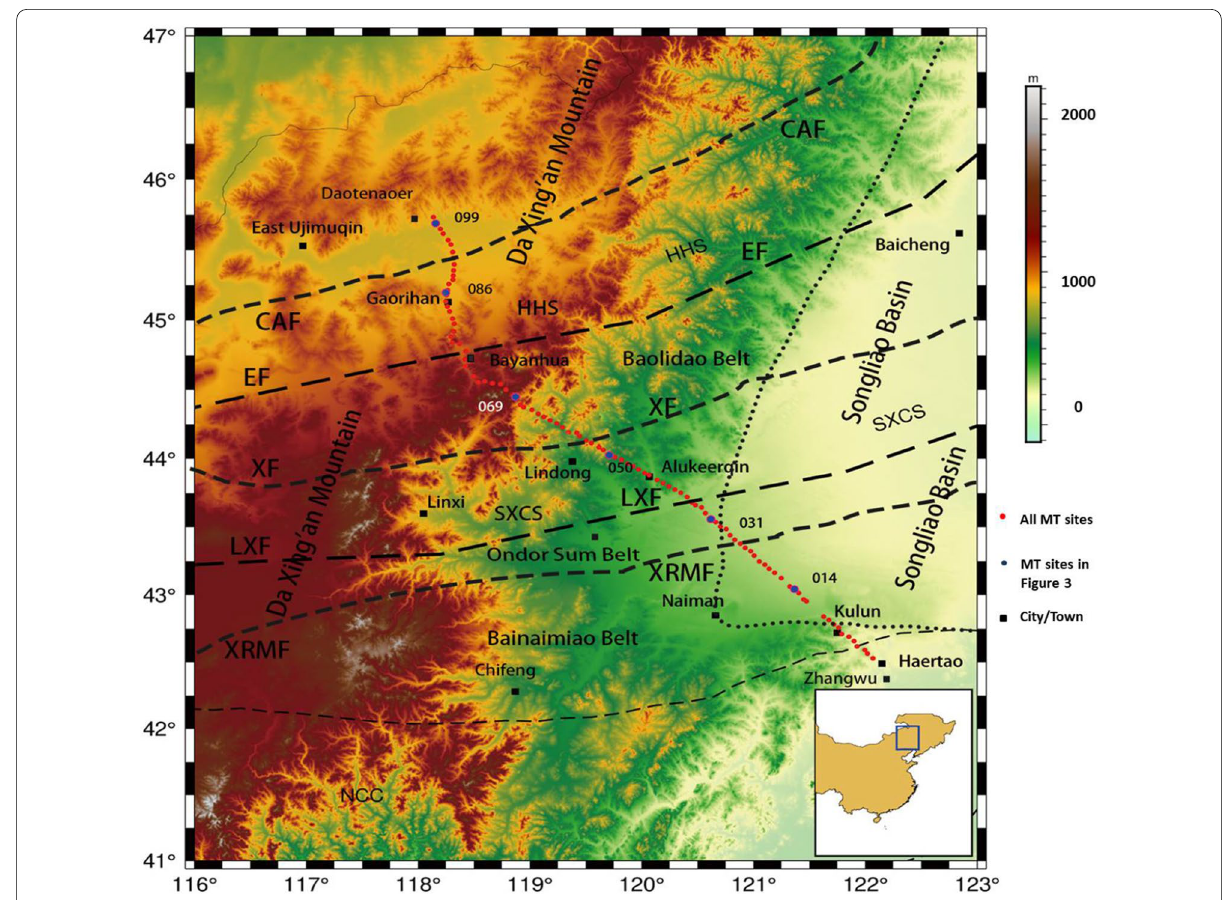
Fig. 1 Map of site locations. HHS represents the Hegenshan–Heihe Suture, and SXCS represents the Solonker-Xar Moron-Changchun Suture. In this paper, we use the Hegenshan Suture and Solonker Suture as abbreviations, respectively. NCC represents the North China Craton. CAF, EF, XF, LXF, and XRMF represent the Chagan Obo fault, the Erlian–Hegenshan Fault, the Xilinhot Fault, the Linxi Fault, and the Xar Moron River Fault,